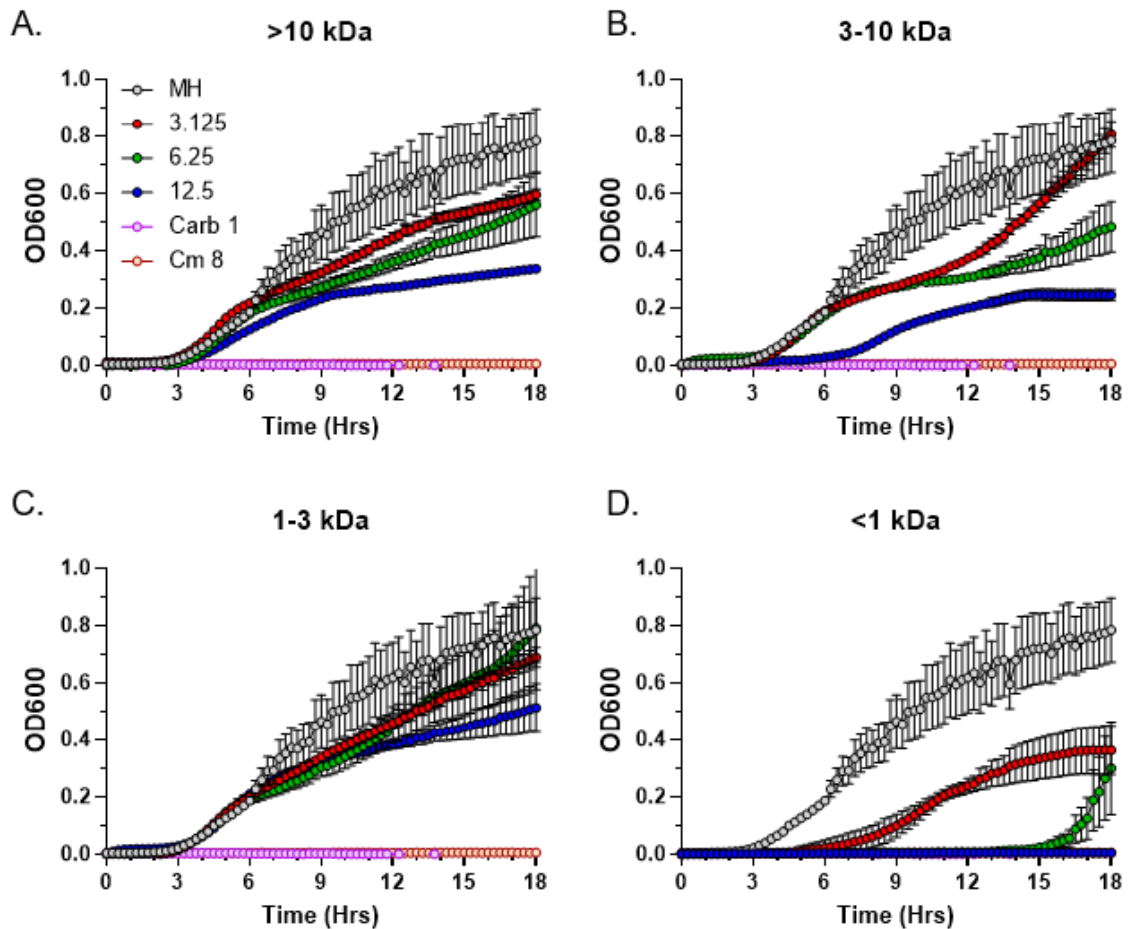
Figure 6. Size fractionation of C. purpureus exudates. Exudate from four-week-old C. purpureus R40 exudate was fractionated into four molecular weight fractions: >10 kDa ( A ), 3–10 kDa ( B ), 1–3 kDa ( C ), and <1 kDa ( D ). Each exudate fraction was analyzed by MIC assay at three different concentrations (3.125, 6.25, and 12.5 mg/mL) against S. aureus ATCC25923. MH medium without exudate addition was used as the negative control. Carbenicillin (Carb, 1 µg/mL) and chloramphenicol (Cm, 8 µg/mL) were used as positive controls.